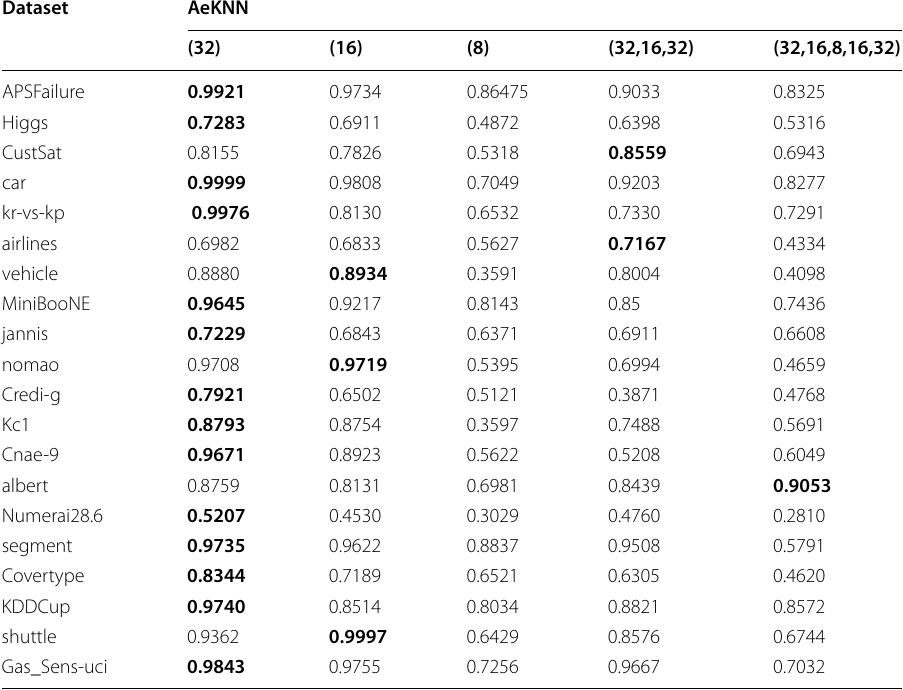
Table 4 Accuracy classification results of the recommended pipelines for the considered AeKNN architectures